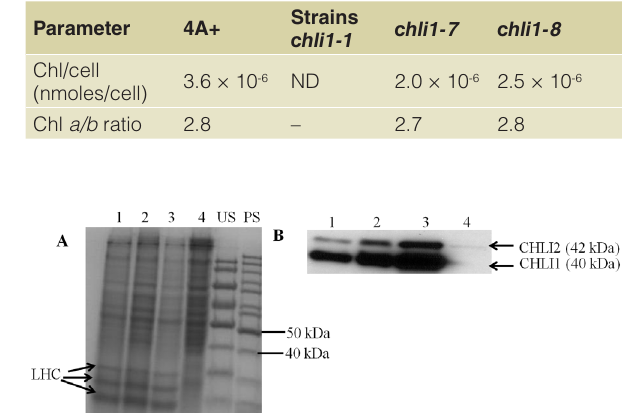
Table 5. Spectrophotometric analyses of chlorophyll in 4A+, chli1-1 , chli1-7 and chli1-8 strains. Chlorophyll analyses were done on three biological replicates for each strain. Strains were grown mixotrophically in TAP under 15–20 μmol photons m -2 s -1 . Mean values are shown in the table. Statistical error (± SD) was ≤ 10% of the values shown. ND: not